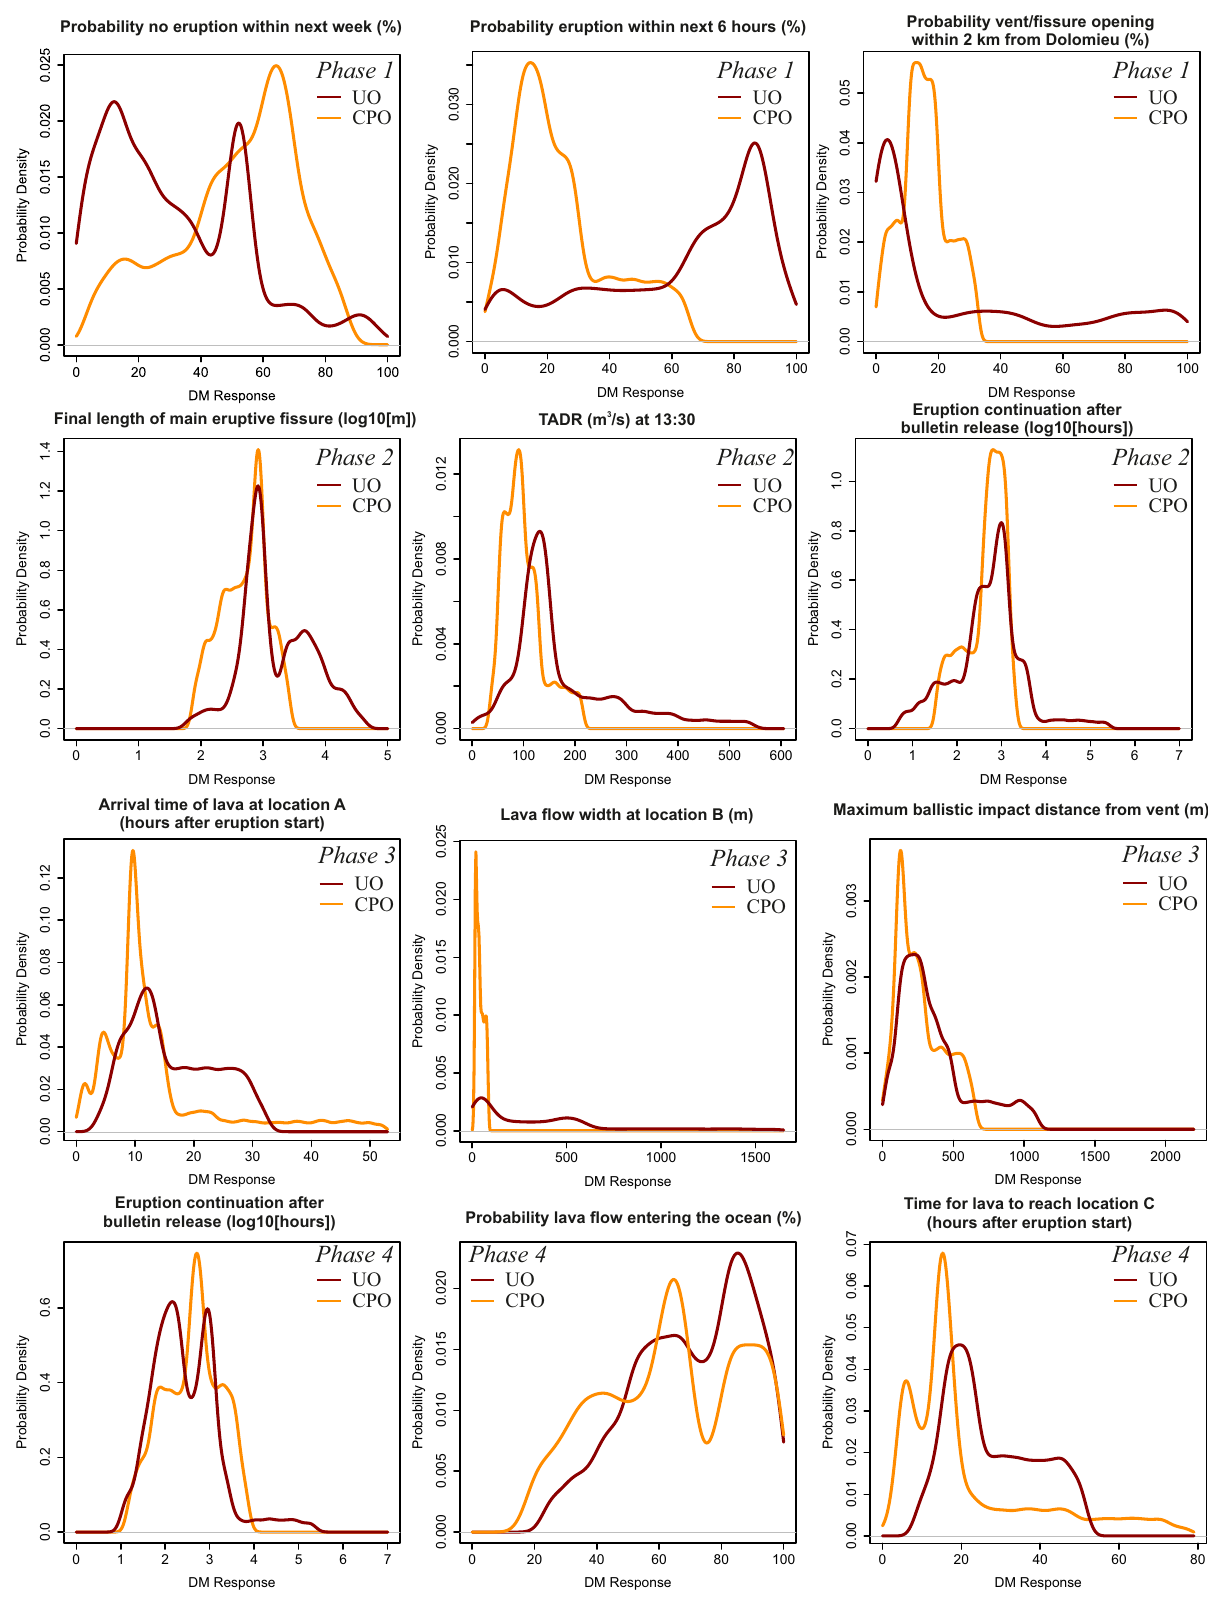
Figure 6: Probability density functions for the decision maker (DM) obtained with the Classical Model pooling method for the “University/Observatory staff” (UO—dark red lines) and “Civil Protection officers/Others” ( CPO— orange lines). For Q1 & Q3 in Phase 2 and Q1 in Phase 4, the x axis is a logarithmic